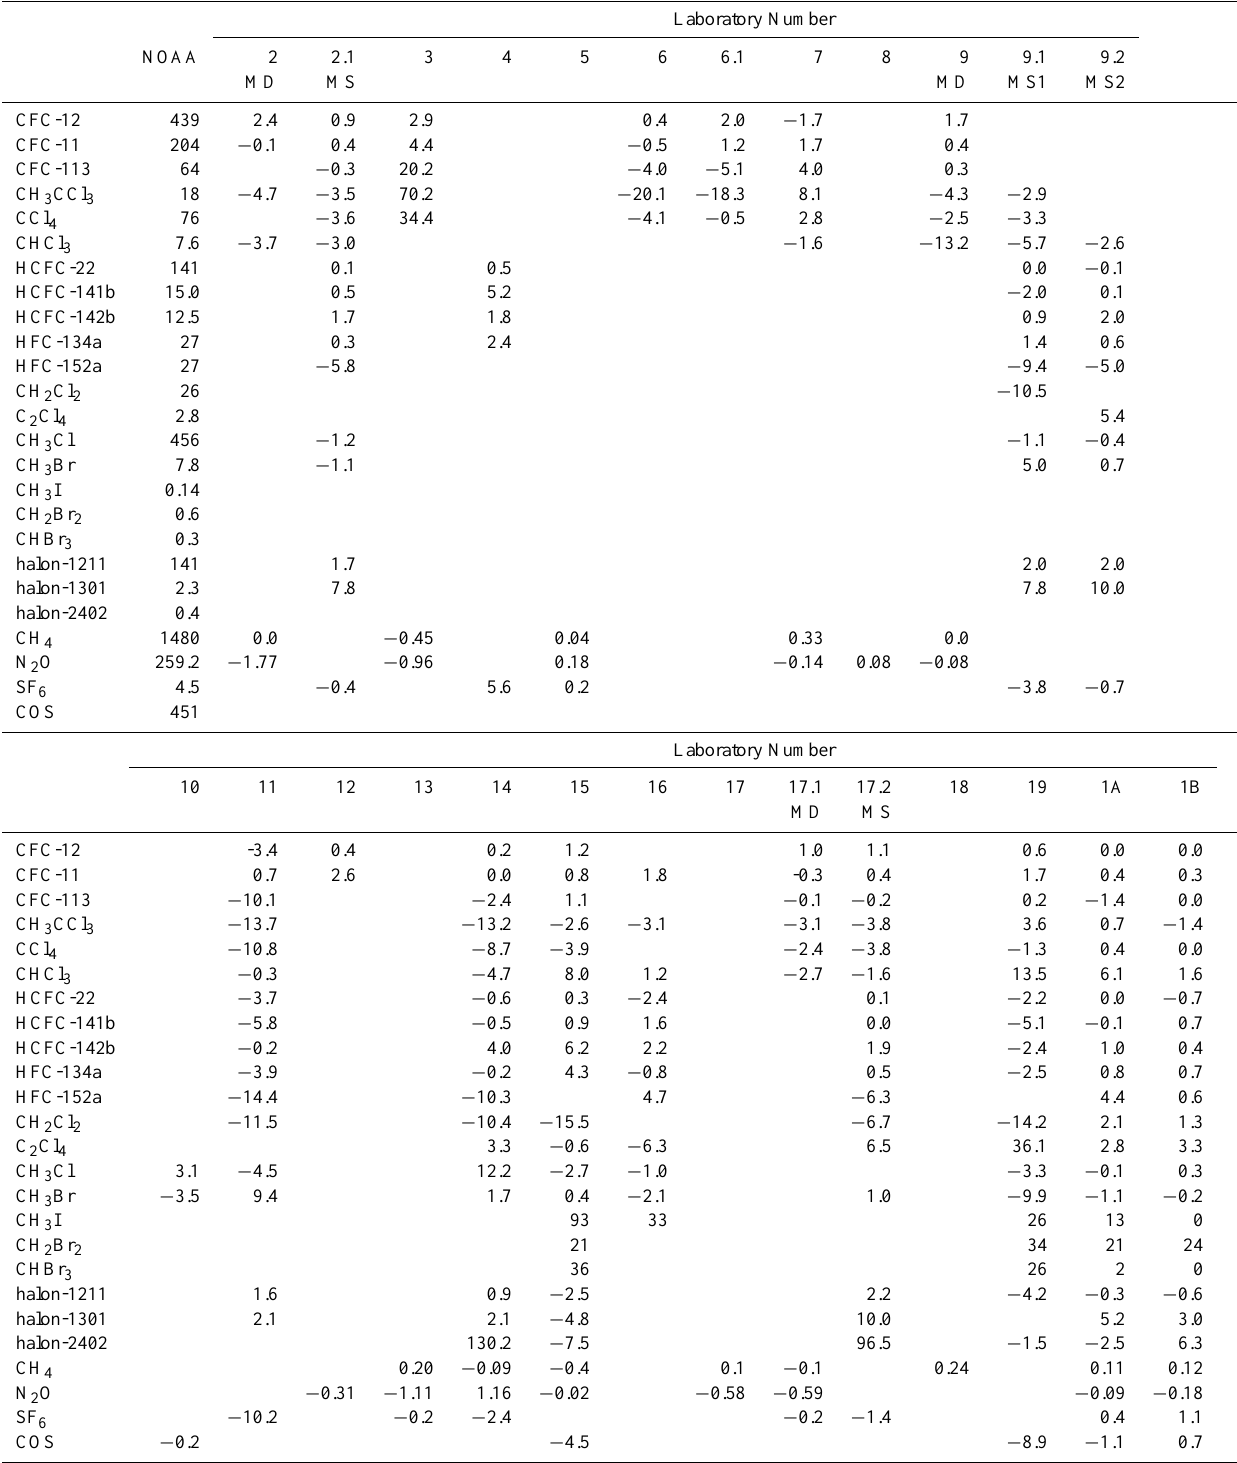
Table 4. Same as Table 3 but for diluted